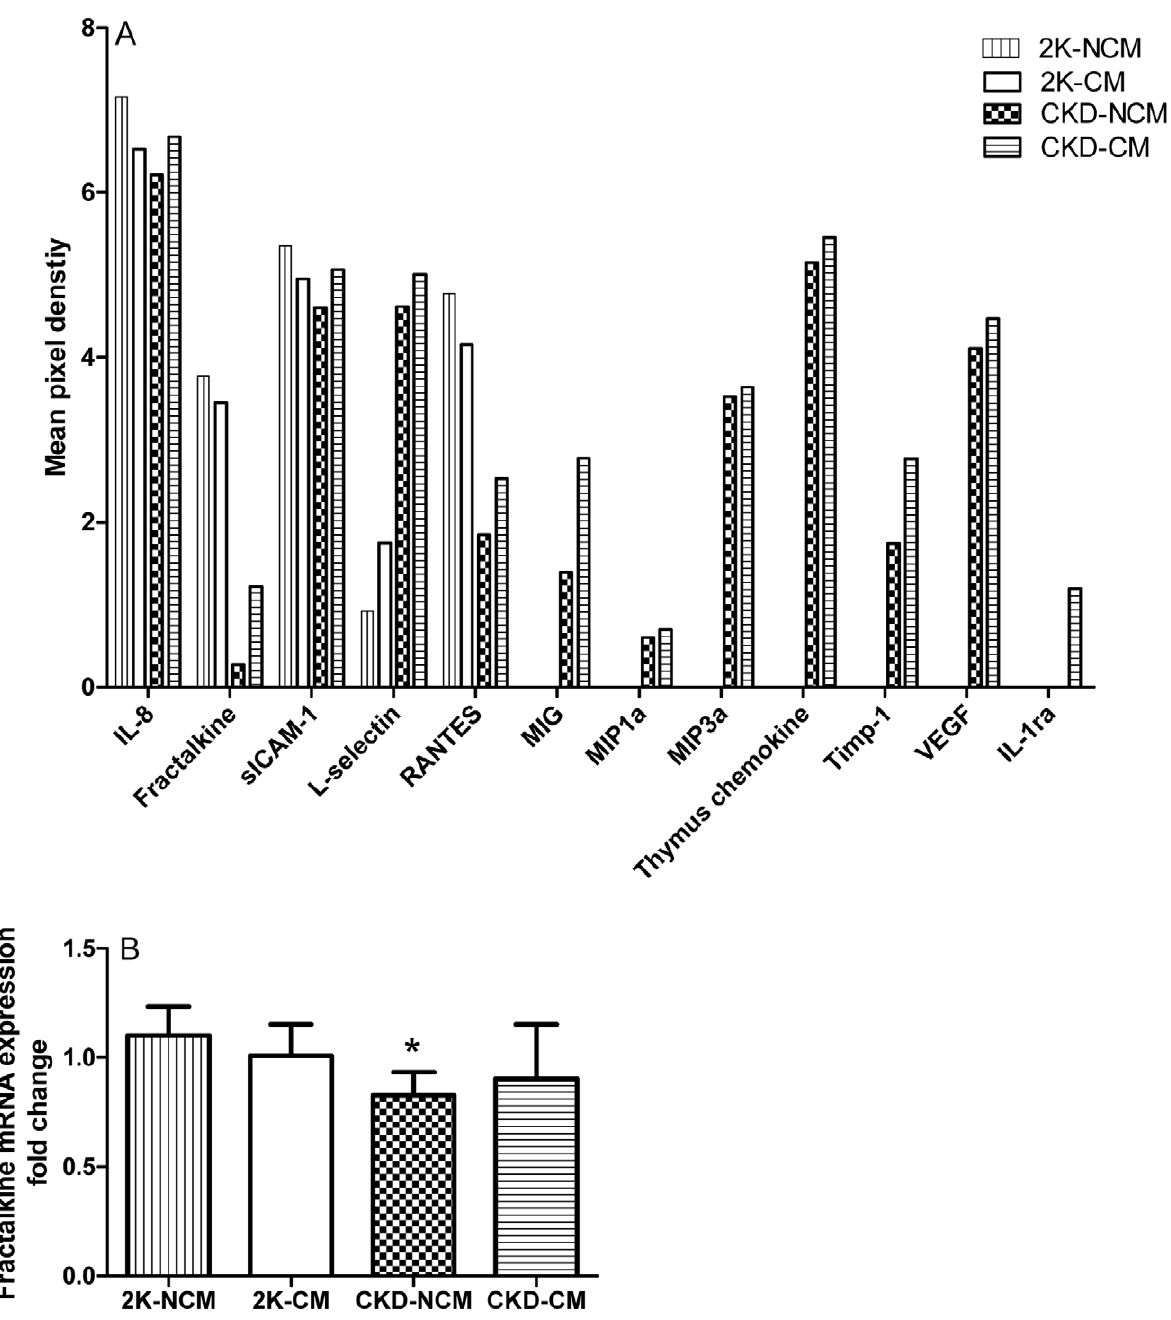
Figure 8. Inflammatory cytokine expression in healthy and CKD kidneys. A: Cytokine array in array. Striped bars=2K-CM (n=6); dotted bars=2K-NCM (n=6); black bars=CKD-NCM (n=7); white bars=CKD-CM (n=4). IL-8=interleukin 8; sICAM=soluble Inter-Cellular Adhesion Molecule; L-selectin=leucocyte cell-adhesion molecule; RANTES=Regulated upon Activation, Normal T-cell Expressed, and Secreted; MIG=Mono- kine Induced by Gamma-Interferon; MIP1 a =Macrophage Inflammatory Protein-1 alpha; MIP3 a =Macrophage Inflammatory Protein-3 alpha; Timp- 1=Tissue Inhibitor of Metalloproteinase 1; VEGF=Vascular Endothelial Growth Factor; IL-1RA=Interleukin 1 Receptor Antagonist. B: Fractalkine mRNA in healthy and CKD kidneys. Striped bars=2K-CM (n=6); dotted bars=2K-NCM (n=6); black bars=CKD-NCM (n=7); white bars=CKD- CM (n=4). *P , 0.05: CKD vs. 2K.